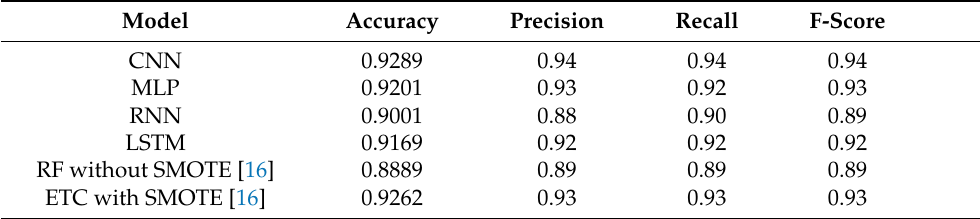
Table 5. Performance comparison of the proposed CNN deep neural network models with RF & ETC [16].